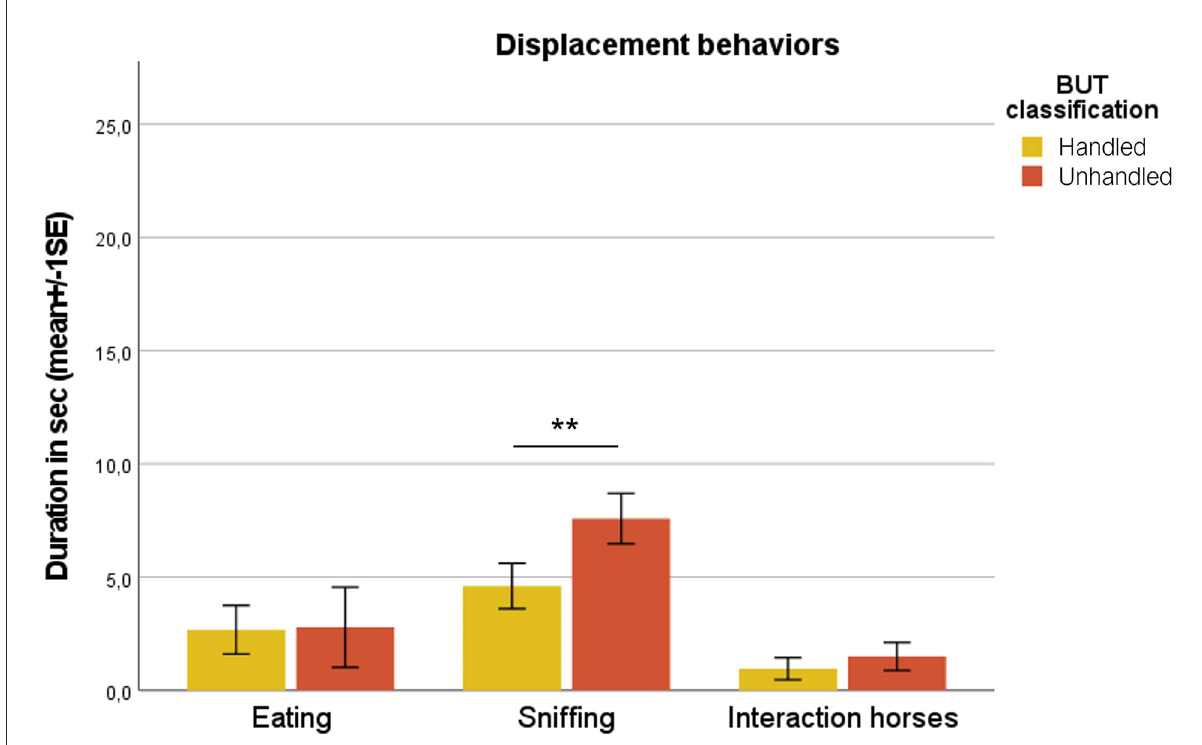
FIGURE3 Mean durations in seconds (1 SE) referred to displacement behaviors in broken and unbroken group. Mann–Whitney test; ** p <